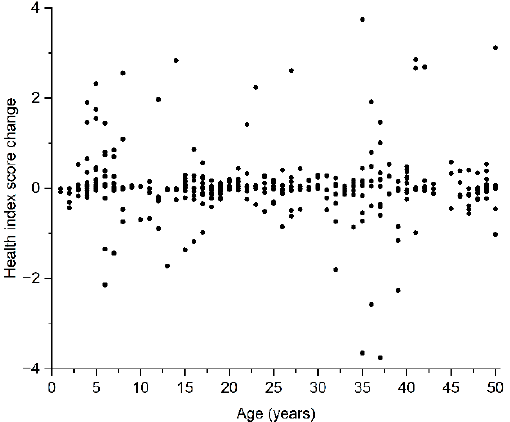
Figure 4. The annual changes in the HI score between successive tests in the study group.